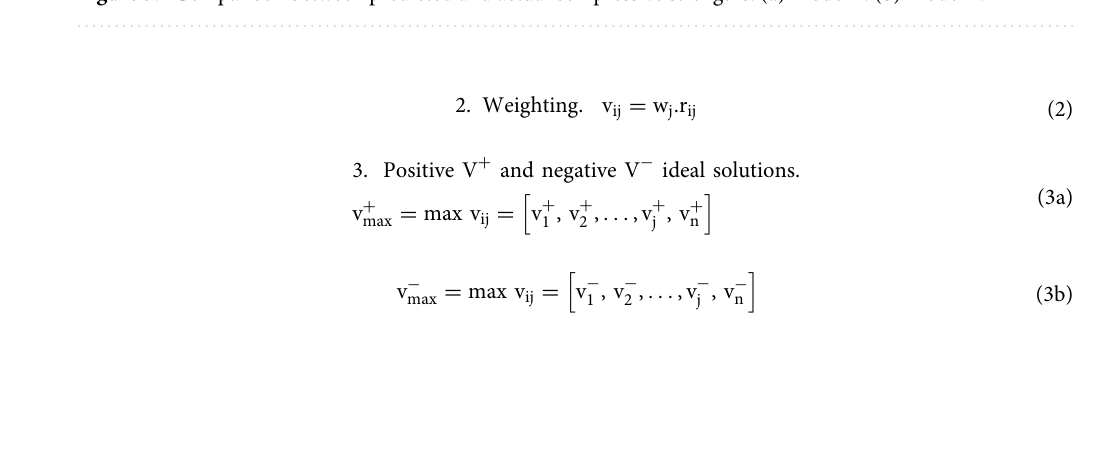
Figure 5. Comparison between predicted and actual compressive strengths. ( a ) Model 1. ( b ) Model